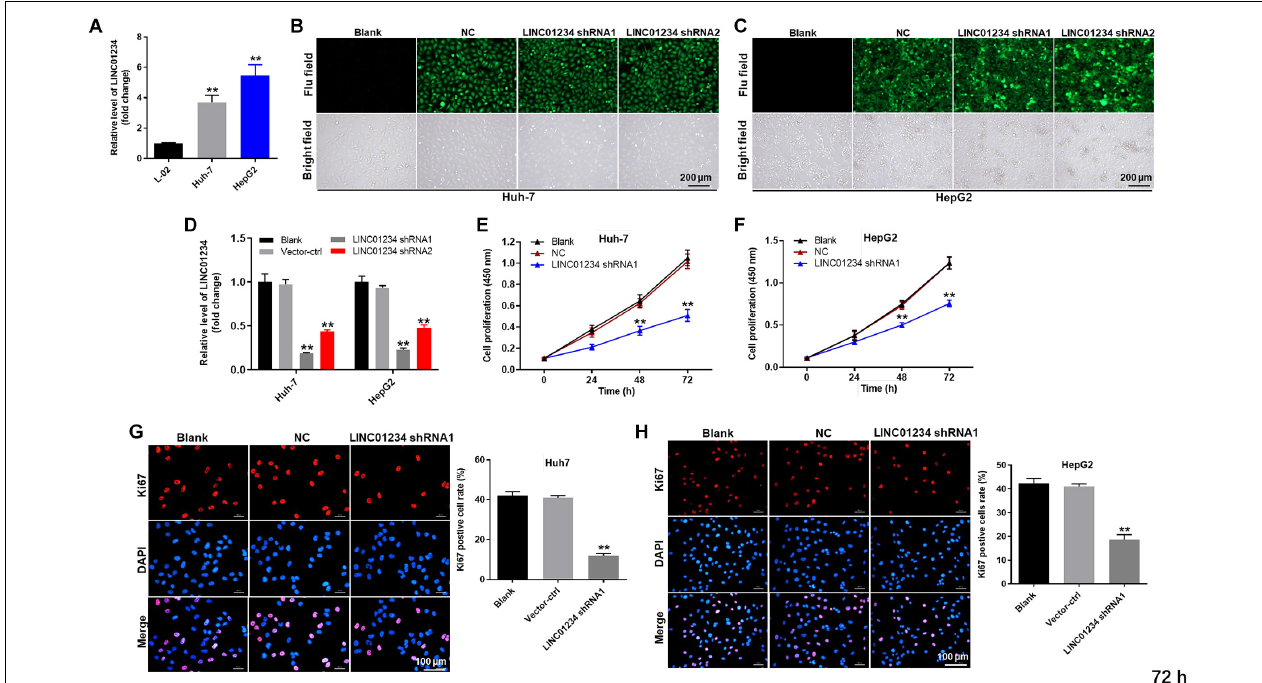
FIGURE 2 | LINC01234 knockdown significantly decreased the proliferation of liver cancer cells. (A) The expression of LINC01234 in Huh-7, HepG2 and L-02 cells was detected by qRT-PCR. (B,C) Huh-7 cells were transfected with LINC01234 shRNA1 or shRNA2 for 24 h. Then, the efficiency of cell transfection was detected by green fluorescence staining. (D) The expression of LINC01234 in liver cancer cells was detected by qRT-PCR. The proliferation of (E) Huh-7 or (F) HepG2 cells was detected by CCK-8 assay. (G,H) Ki67 staining was performed to test the proliferation of Huh-7 and HepG2 cells. Red indicates the Ki67 staining. Blue indicates DAPI staining. ** P < 0.01 compared to